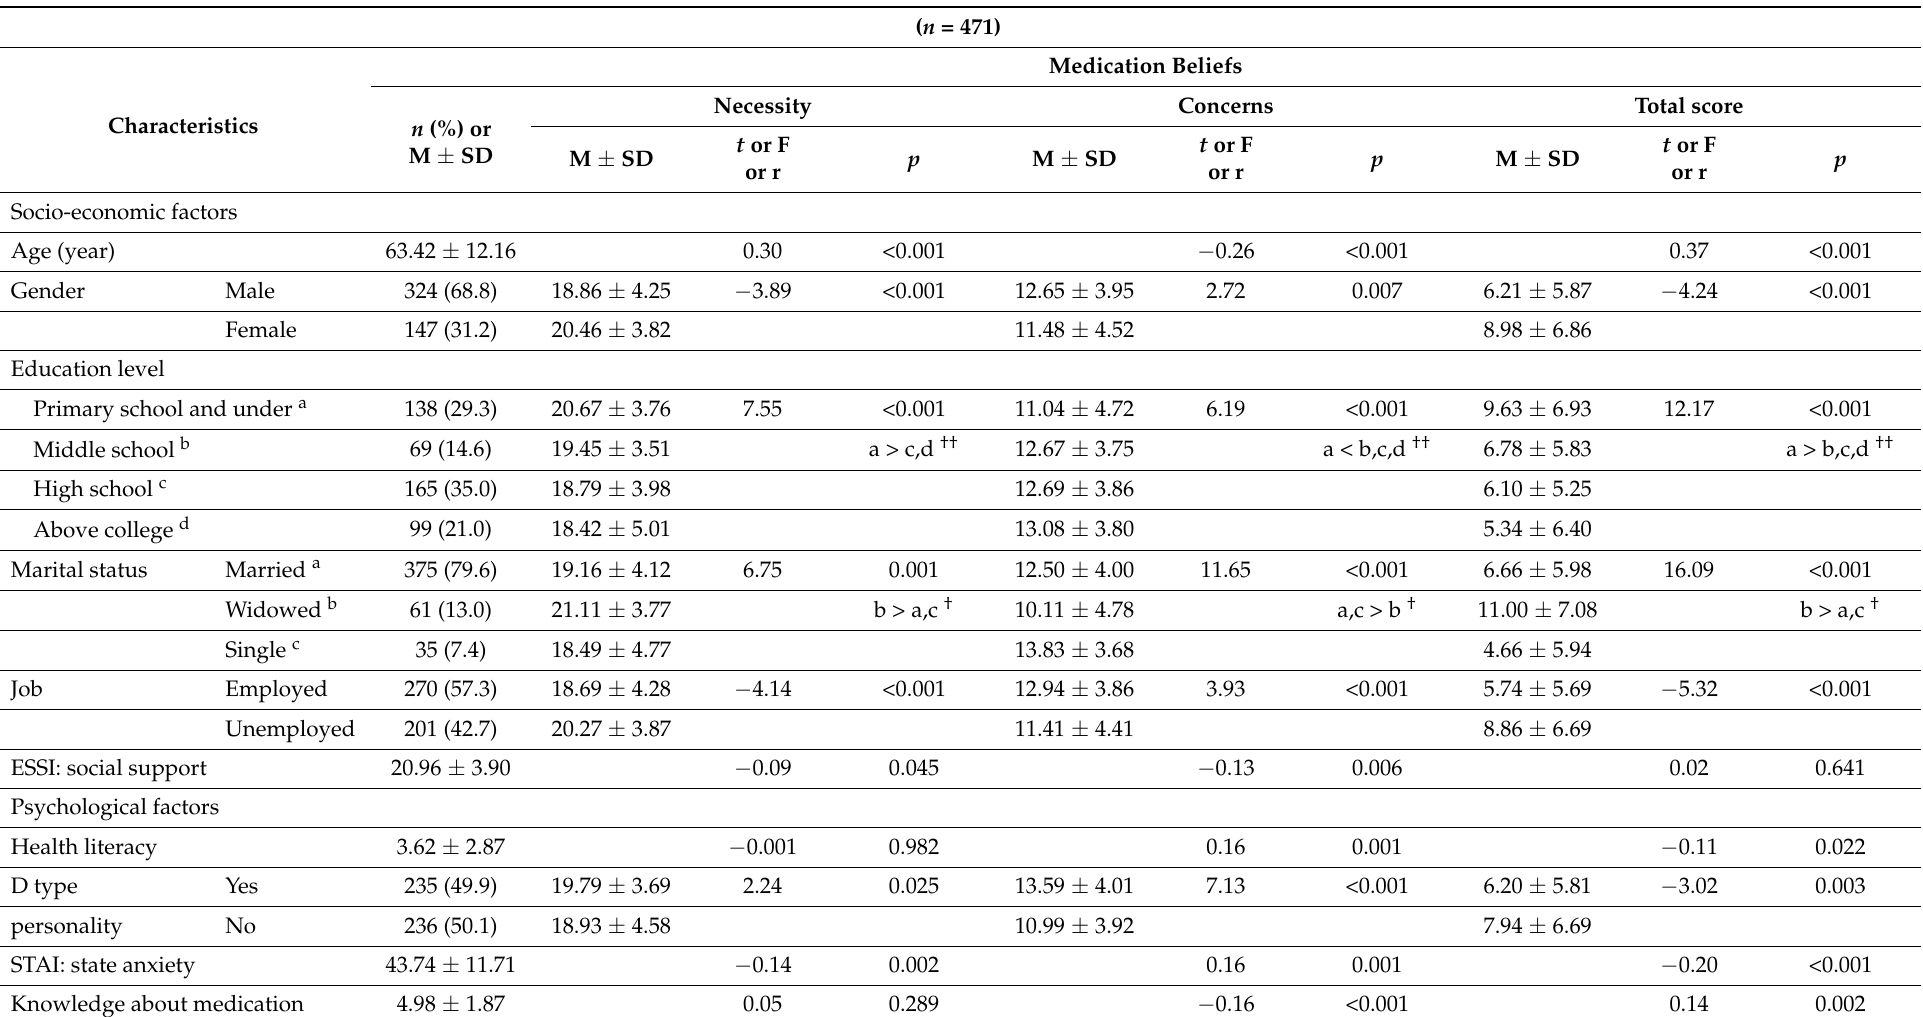
Table 1. Factors related to necessity, concerns, and medication beliefs by univariate